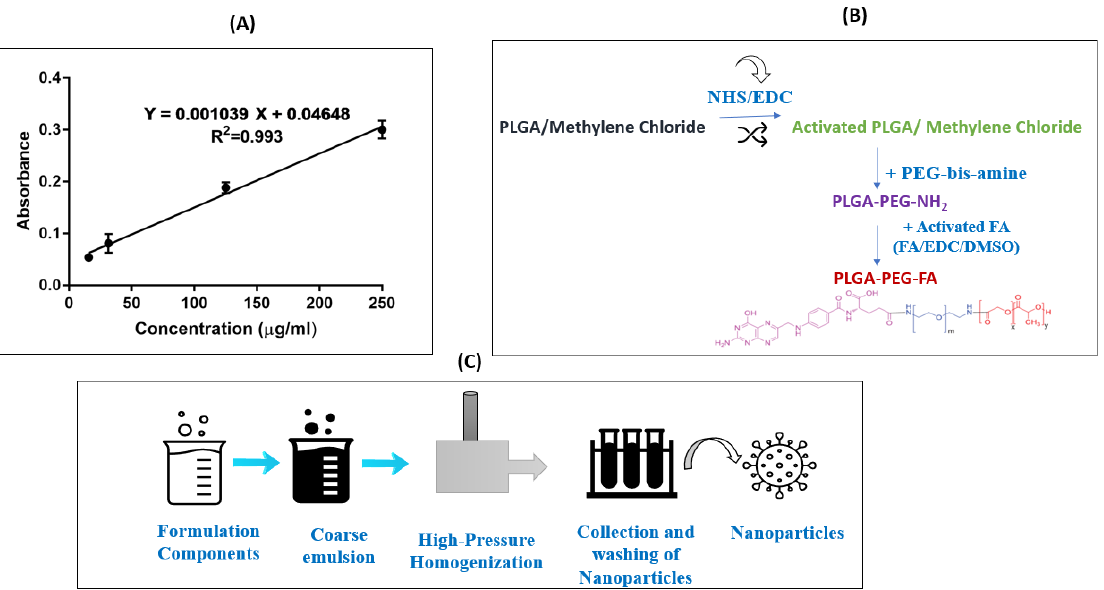
Figure 1. ( A ) Calibration curve for FA. ( B ) Schematics of PLGA conjugation with folic acid. ( C ) Graphical representation of nanoparticles’ preparation.